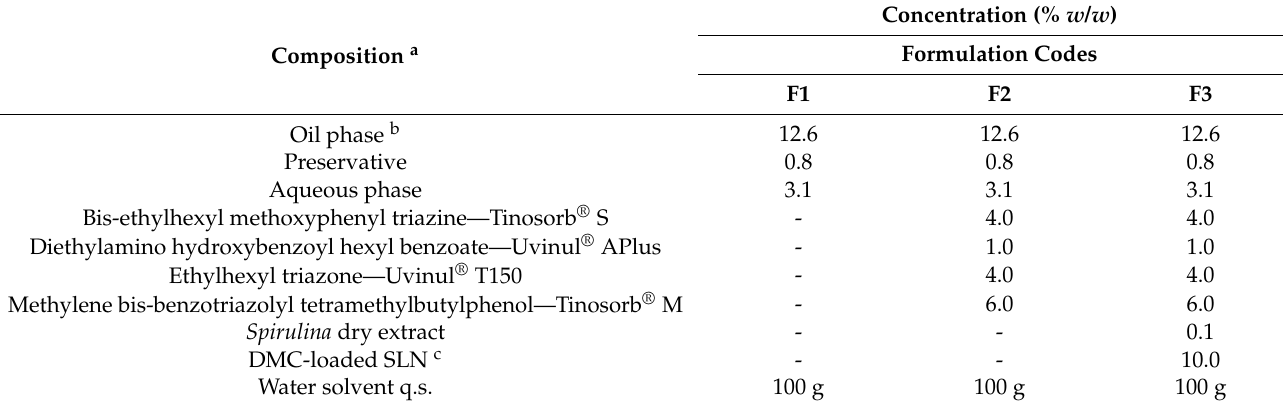
Table 3. Composition of the sunscreen cream based on UV filters and antioxidants. Published by Ref. [34].